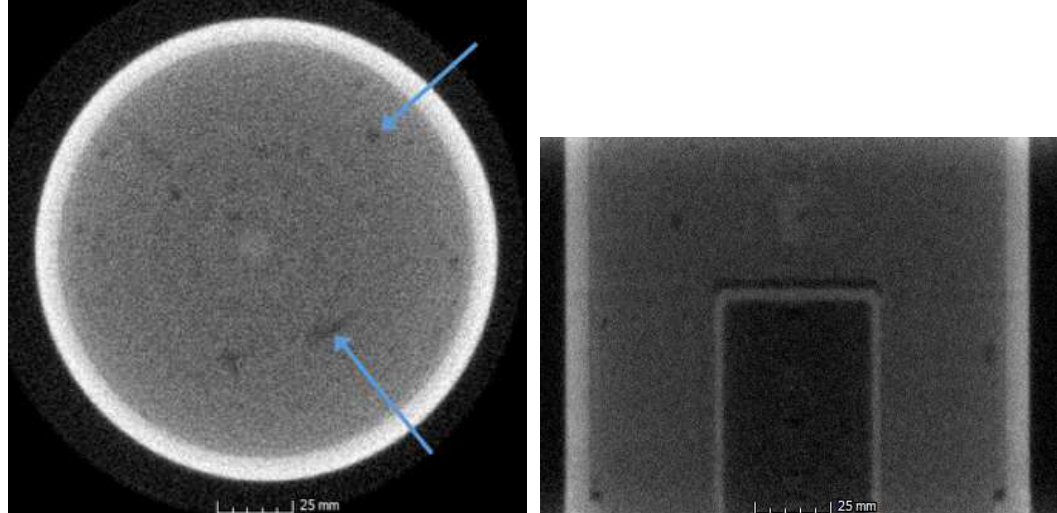
Figure 7. Left : No hard hits are observed in any slices in the corrected reconstruction. A sample slice is shown, with blue arrows indicating features examined via lineout (see Figure 8); Right : A side profile of the 3-dimensional reconstructed volume. Note that the intensity fluctuations (striping) in the side profile are no longer apparent. Visualizations created in Volume Graphics’ VGStudio Max (for information on VGStudio Max, see